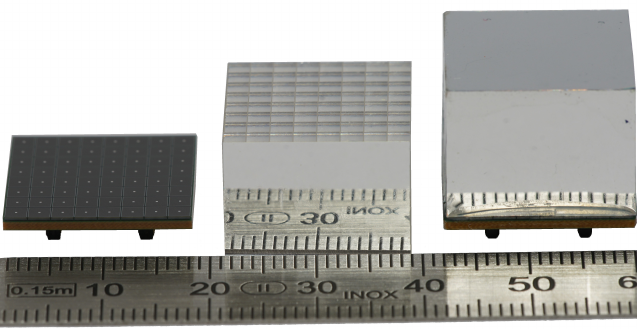
Figure 6. Image of SAFIR-I’s LYSO crystal assembly. The front reflective foil has been removed from one crystal block to showcase the crystal matrix. Crystal blocks (in the middle) are glued onto 8 × 8 Hamamatsu MPPC arrays (on the left) to form the completed assembly (on the right). The photo sensors are Hamamatsu Photonics K.K. 8 × 8 MPPC arrays, type S13361- 2050AE-08 SPL0, composed of 2.0 mm × 2.0 mm SiPM sensors with a pitch of 2.2 mm